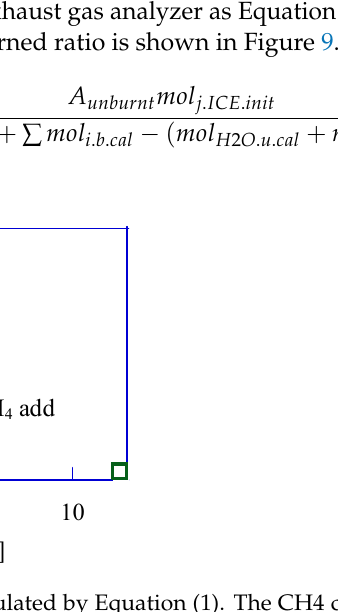
Figure 9. The unburned ratio is calculated by Equation (1). The CH4 case shows a low unburned ratio with a small amount of additional.